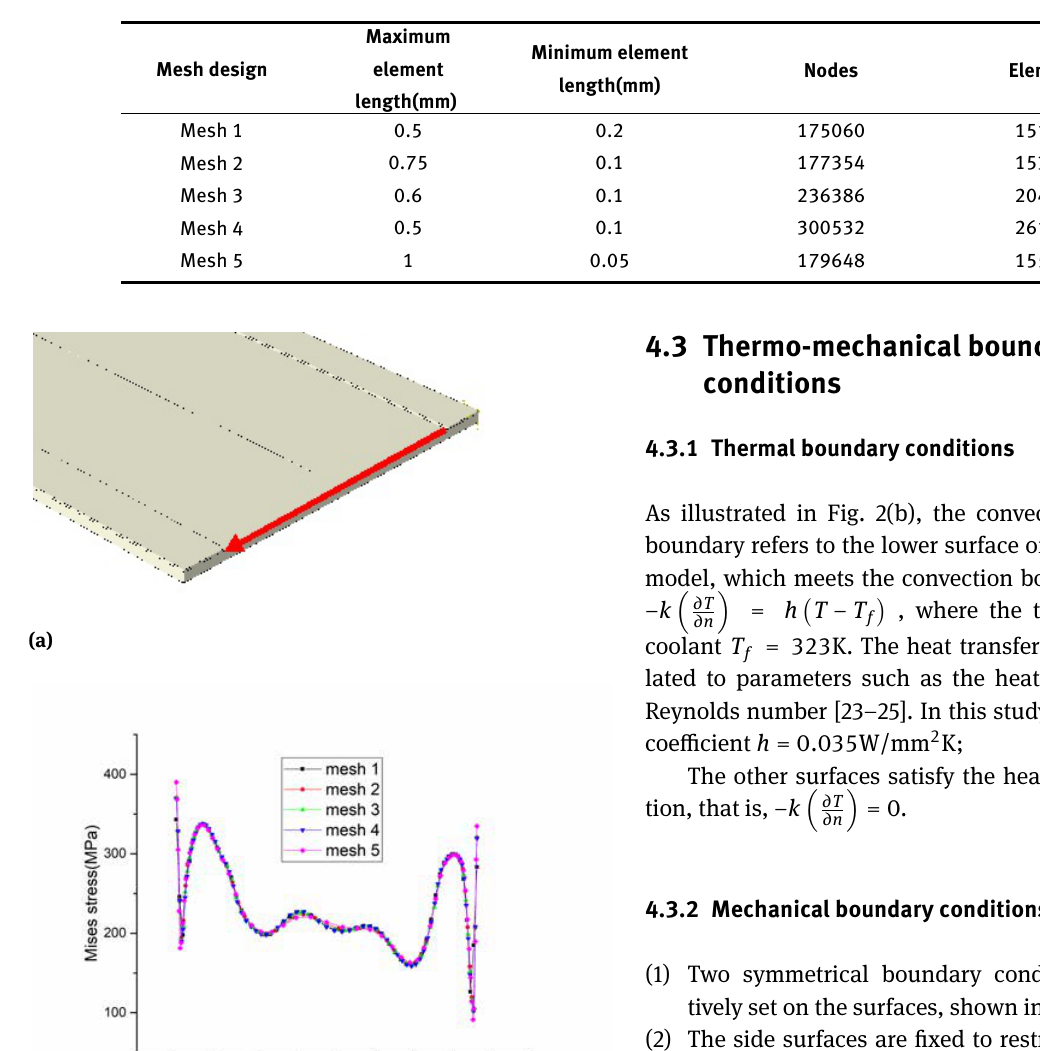
Table 2: Different mesh designs